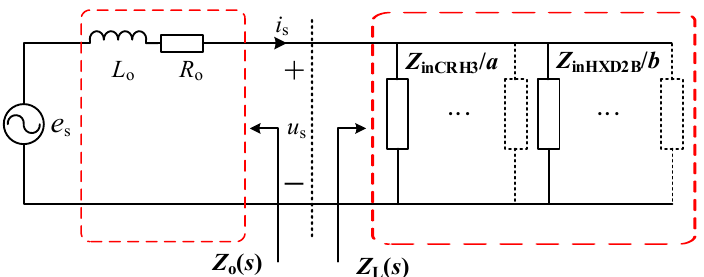
Figure 7. Schematic diagram of the equivalent impedances of the whole vehicle–grid coupling system.